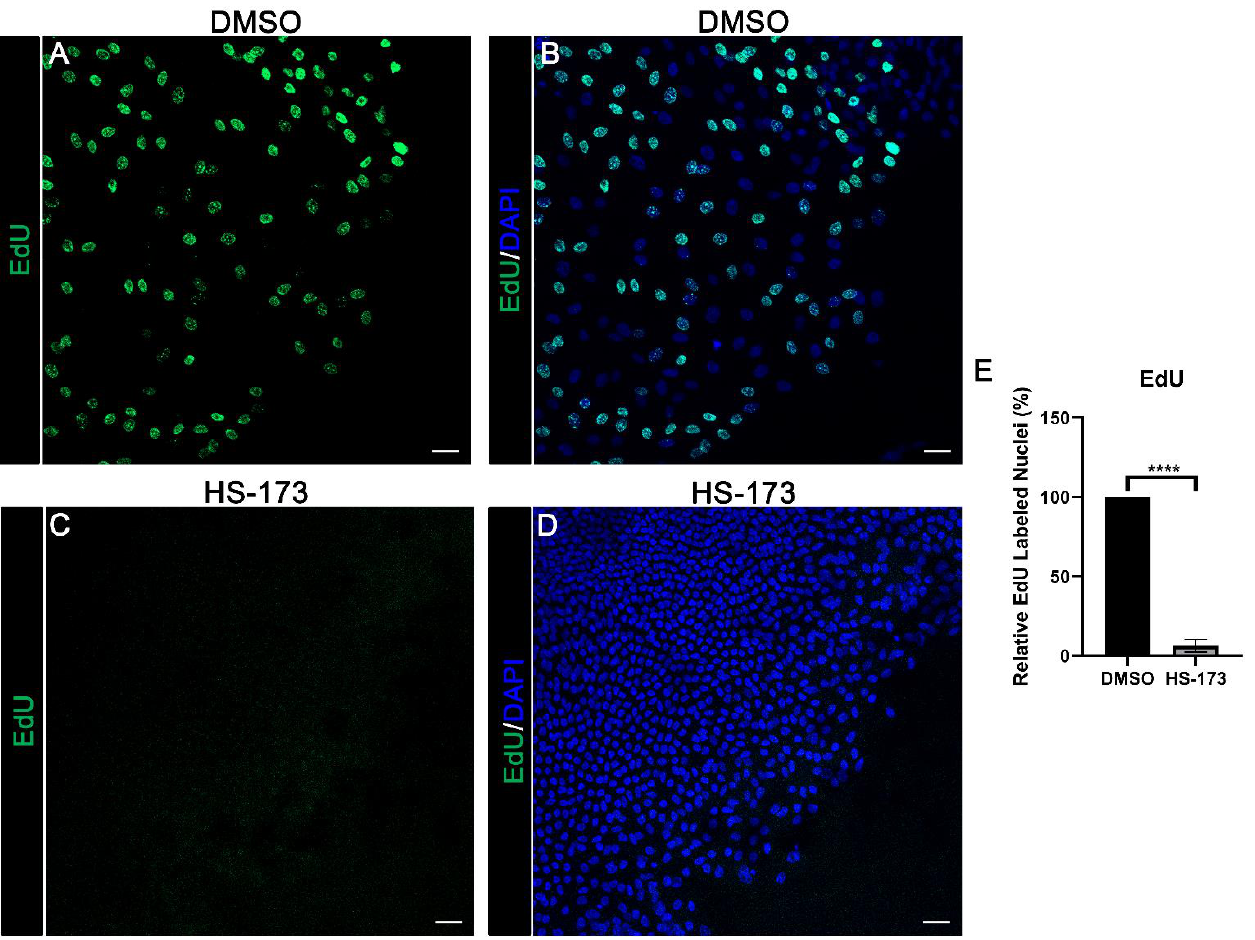
Figure 7. p110 α is required for promoting cell proliferation in the central migratory zone during wound healing. ( A – E ) Time 0 ex vivo post-cataract surgery explants were treated with vehicle (DMSO) or HS-173 to inhibit p110 α for 24 h (Day 1 post-injury) and labeled for 30min with EdU (green) ( A , C ) and counterstained with DAPI (blue) ( B , D ). ( E ) Graph depicts the change in the relative % of EdU positive cells within the CMZ region in vehicle compared to HS-173 treated cultures. Cell proliferation was blocked with HS-173 treatment. Vehicle was normalized to 100%. p -values were determined from unpaired t-test ( E , **** p < 0.0001). Data is expressed as ± SEM from 3 independent experiments ( E ). Magnification bars = 20 μ m ( A – D ).